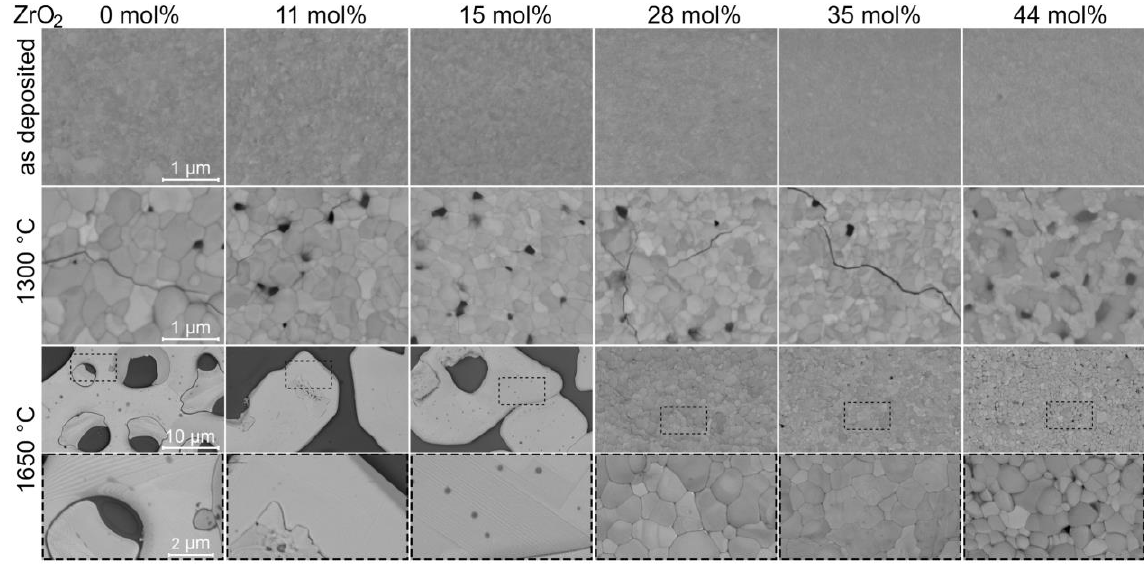
Figure 9. Top view of Y (1−x)/2 Ta (1−x)/2 Zr x O 2 coatings by SEM with 0 to 44 mol% ZrO 2 in as-deposited, annealed for 1 h at 1300 °C, and annealed for 1 h at 1650 °C conditions. For samples annealed at 1650 °C, two magnifications are shown.